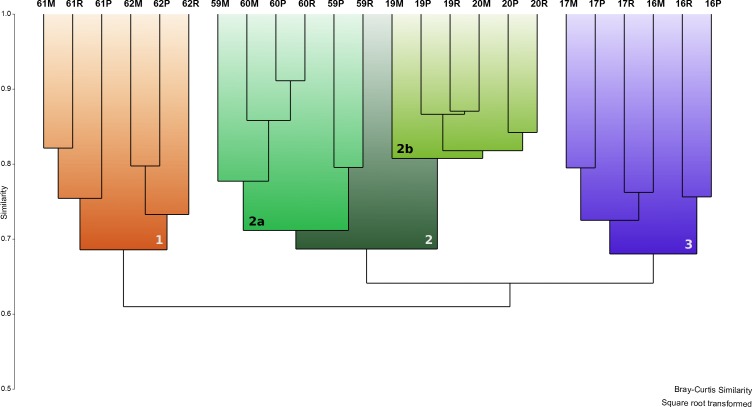
Experimental assemblages (combined replicates) analyzed in a Q-mode cluster.Clusters 1–3 were highlighted at 65% similarity. For sample codes see Table 2.